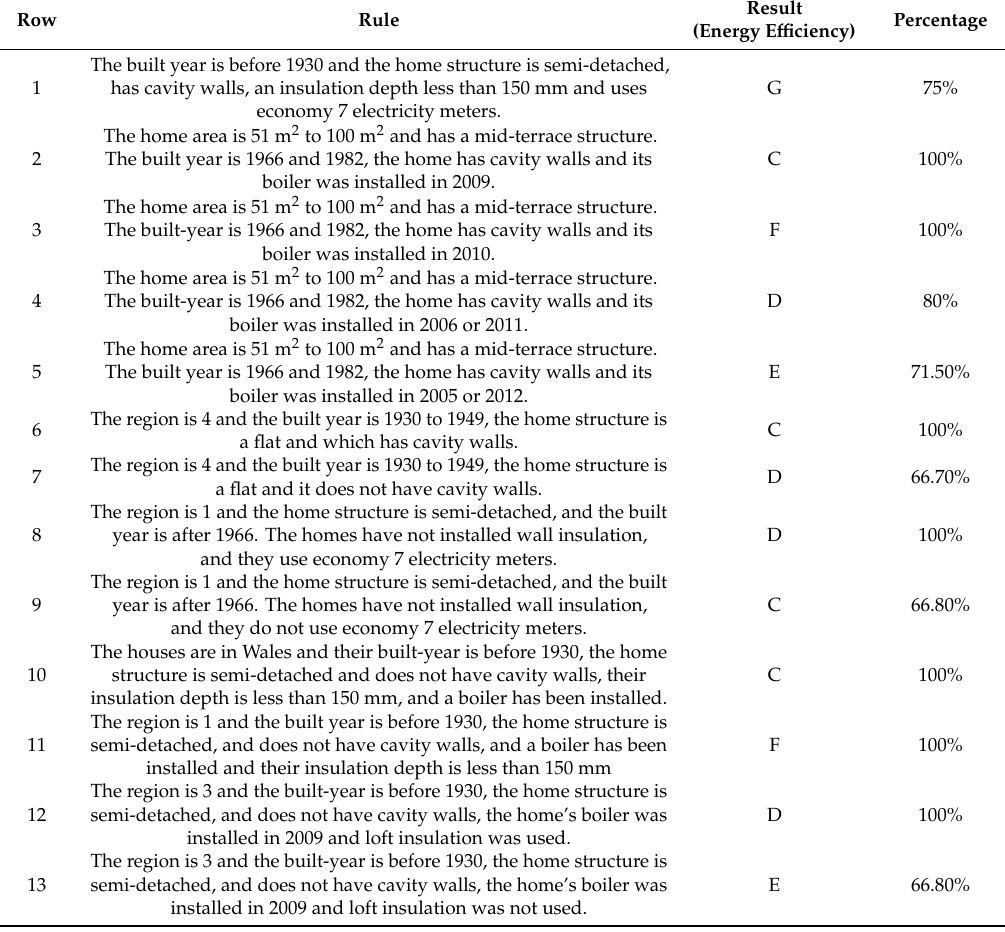
Table 2. The corresponding rules of the C5.0 tree (considering energy e ffi ciency as the target). Row Rule